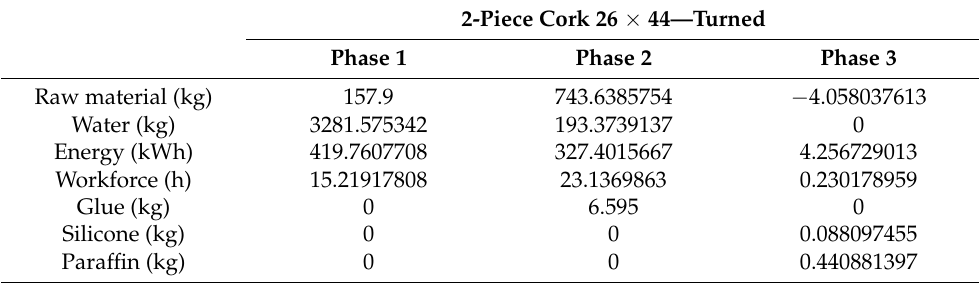
Table 4. Consumptions for 1000 kg raw material used to produce 2-piece stoppers with dimensions of 26 × 44—Turning